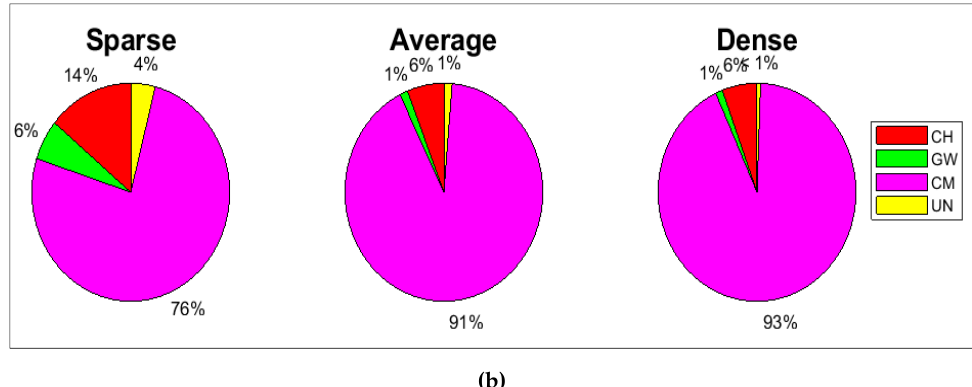
Figure 12. ( a ) Cluster head density ( b ) Cluster state distribution.